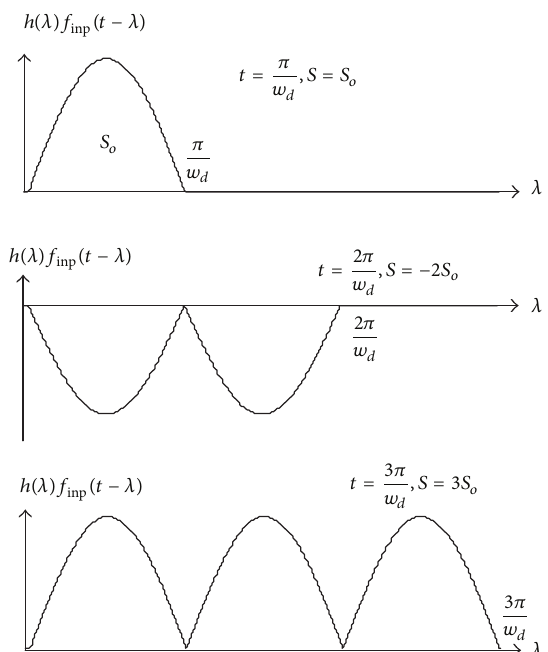
Figure 15: Continuation of the creation of the convolution value, (𝑡 − 𝜆) is shown at three after Figure 14. The function ℎ(𝜆)𝑓 inp intervals 0 < 𝜆 < 𝑡 = 𝑘(𝜋/𝜔 𝑑 ) ≈ 𝑘(𝜋/𝜔 𝑜 ) , 𝑘 = 1, 2, 3 , for which the area under this function of 𝑡 has local extremes, 𝑆 𝑜 = 𝑆(2𝜋/𝜔 𝑑 ) , (𝑡 − 𝜆) . Damping of denotes the area under a half-wave of ℎ(𝜆)𝑓 inp 𝑆 = −2𝑆 ℎ(𝑡) is ignored, and we have here the cases of 𝑆 = 𝑆 𝑜 , 𝑜 , and 𝑆 = 3𝑆 𝑜 , which represent the output function at its extremes; see Figure